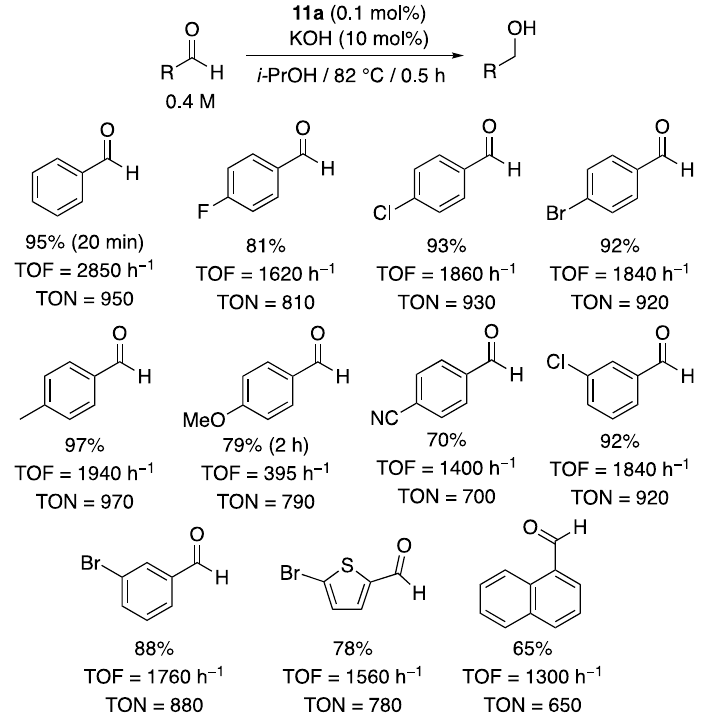
Scheme 16. TH of aldehydes catalyzed by the cyclometalated triazolylidene-phenyl complex 11a